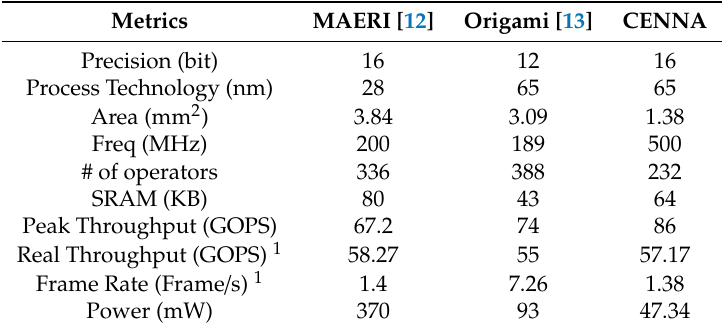
Table 8. Performance comparison with reduction tree-based